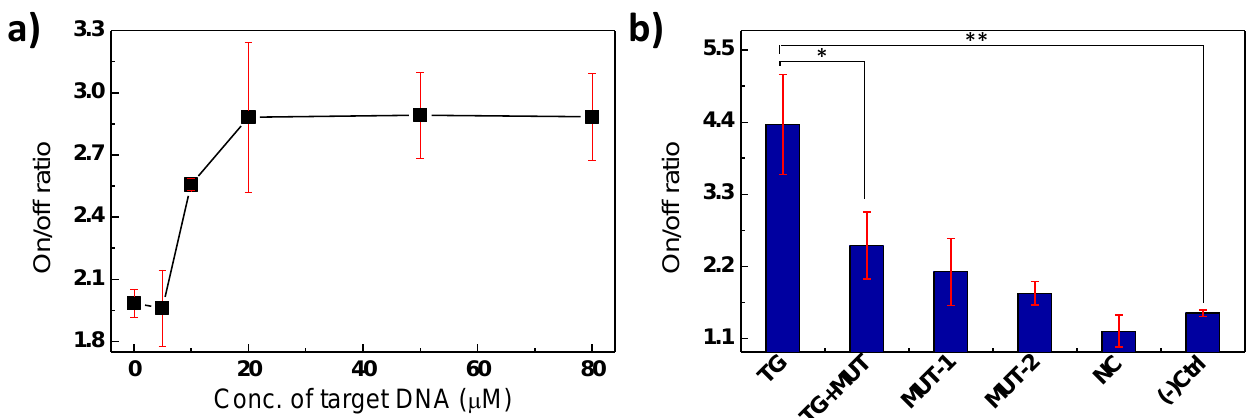
Figure 4. Detection of target oligonucleotide by Au-scaffold sensor. ( a ) Fluorescence turn-on/off ratio of Au-scaffold sensor as a function of the target oligonucleotide concentrations. ( b ) Fluorescence turn-on/off ratio of Au-scaffold sensor to target oligonucleotide (TG), target and mutation mixture (TG+MUT), a single (MUT-1) or double (MUT-2) mismatched mutation, or non-complementary DNA (NC). * and ** are indicated for p < 0.05 and p < 0.01, respectively.